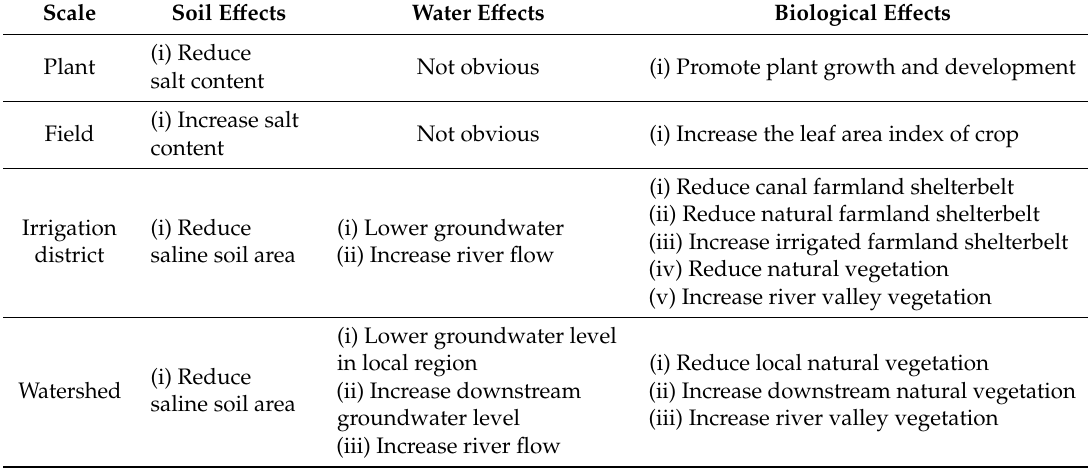
Table 7. Ecological e ff ects of water-saving irrigation at di ff erent